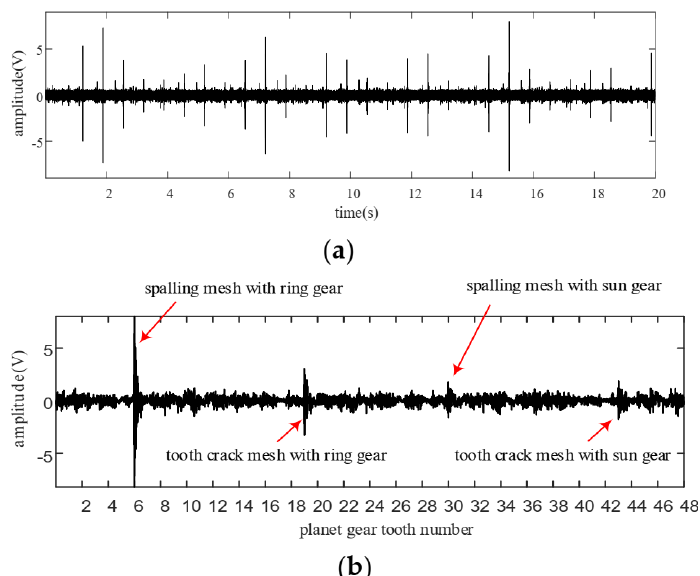
Figure 14. Signal analysis results with compound localized faults on planet gear: ( a ) vibration signal with compound localized faults, ( b ) TVTF-VS